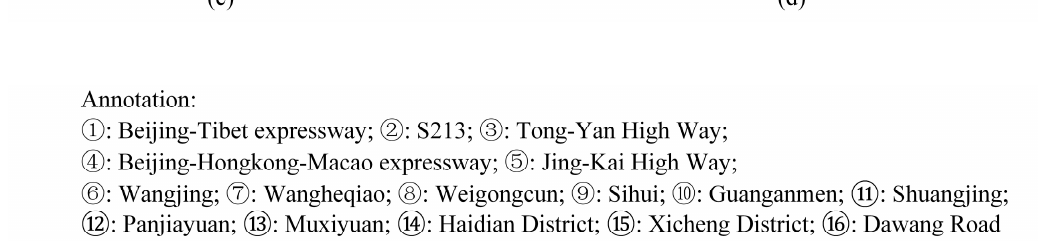
Figure 7. Results of K-means clustering classification (( a ) K-means clustering level division; ( b ) The distribution of tra ffi c-oriented digital signage; ( c ) The distribution of population-oriented digital signage; ( d ) The distribution of market-oriented digital signage).